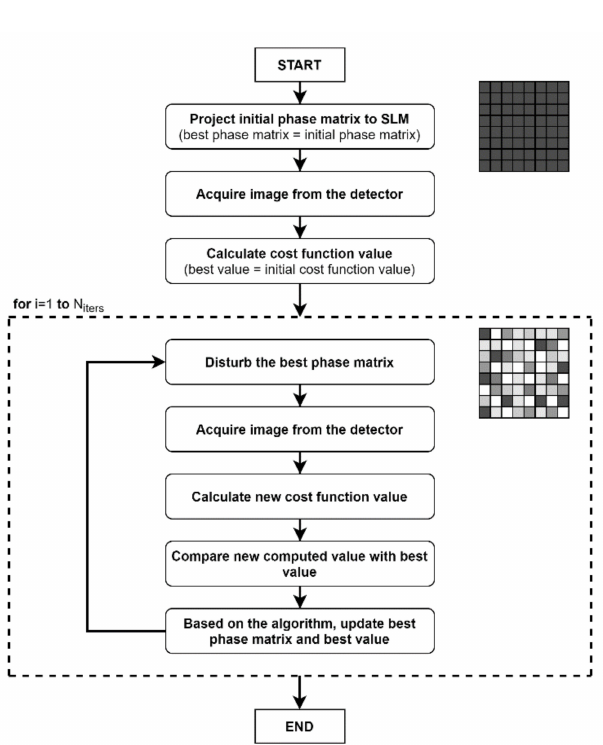
Figure 7. Feedback-based wavefront shaping diagram while using a SLM. The dark squared shape is representing the initial phase matrix applied to the SLM and the one below is representing the disturbed phase matrix, where several segments change its phase